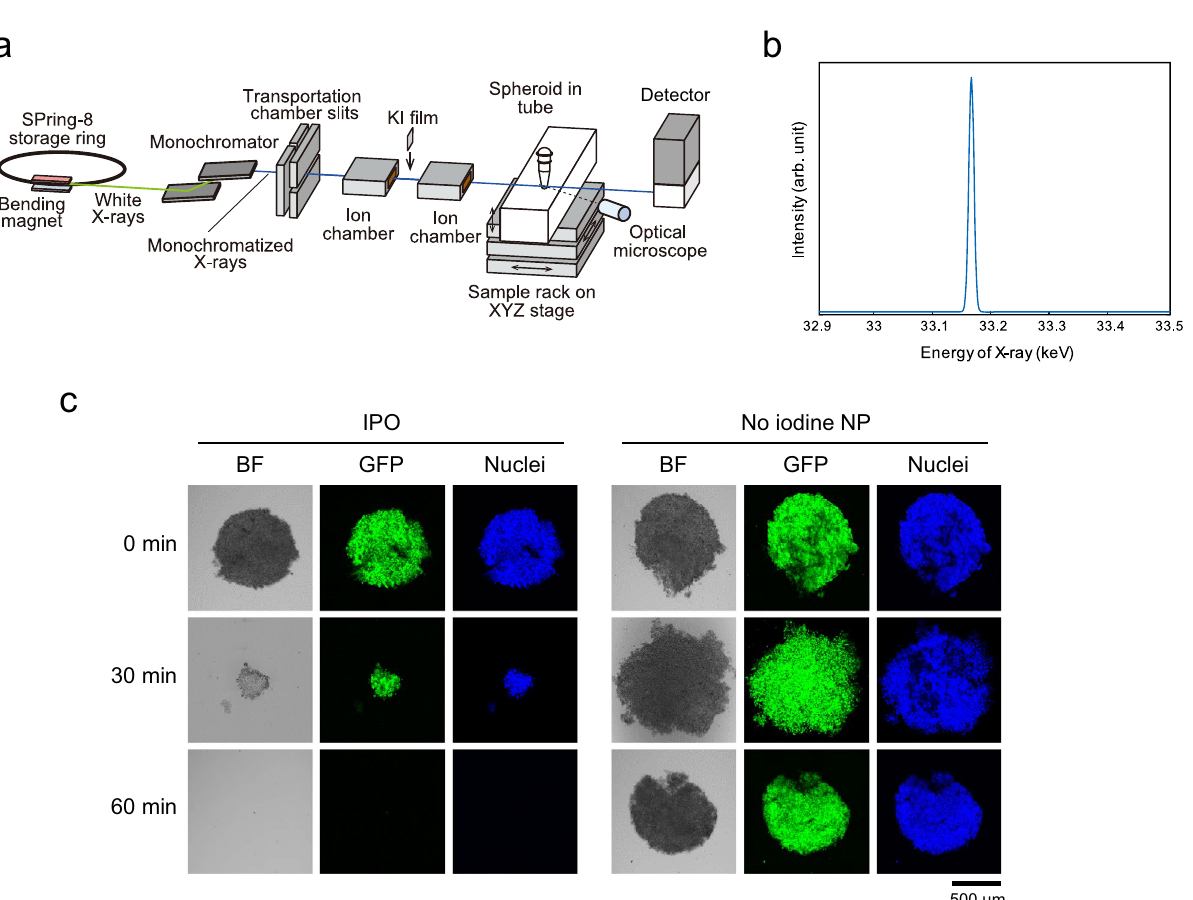
Figure 3. Monochromatic X-rays irradiation to tumor spheroids incubated with IPO. ( a ) Experimental setup for monochromatic X-ray irradiation. ( b ) Energy band width of monochromatic X-ray used in this study. ( c ) Effect of X-ray irradiation time on the destruction of tumor spheroids. OVCAR8 tumor spheroids incubated with IPO were irradiated with 33.2 keV monochromatic X-ray for the indicated time periods and destruction of tumor spheroids was examined. Tumor spheroids incubated with nanoparticles that do not contain iodine were used as no iodine controls (no iodine NP). GFP and nuclear staining were used to follow the